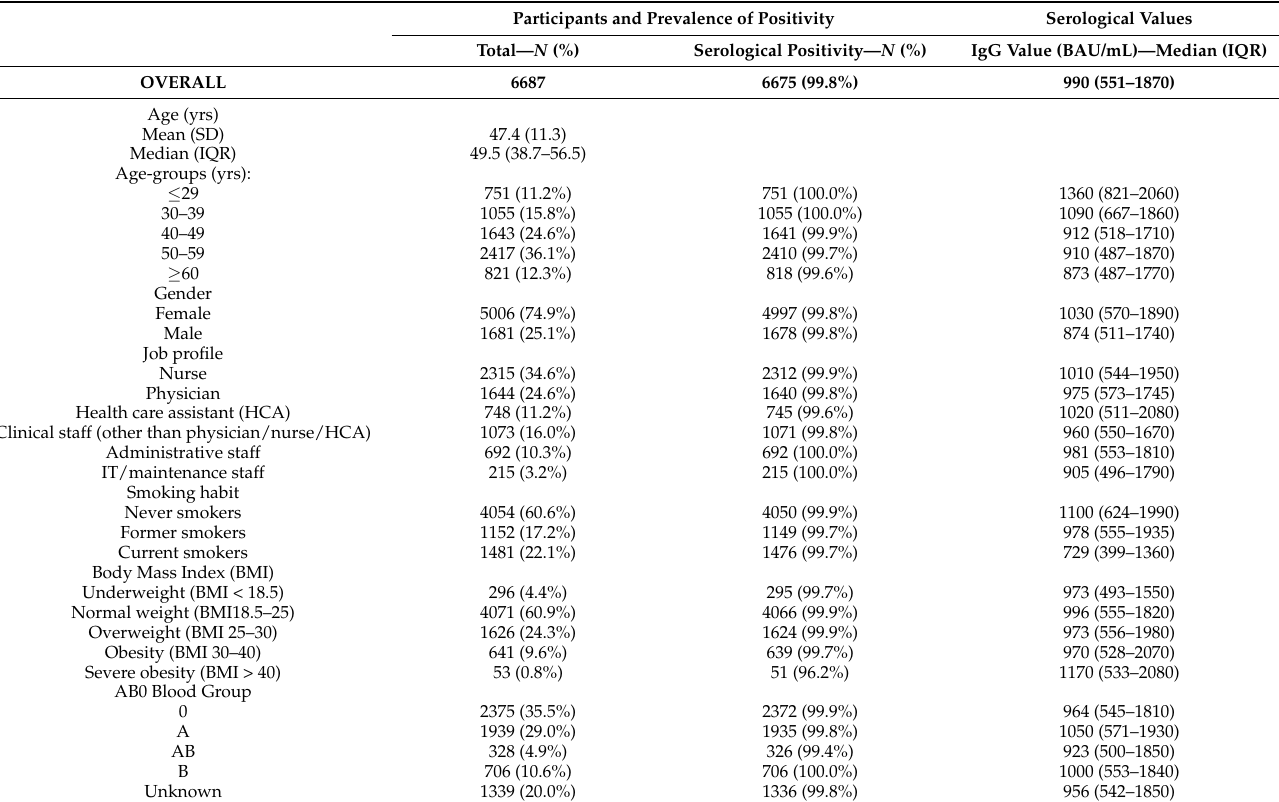
Table 1. Participants (first column), prevalence of seropositivity (second column), and serological values (third column) among 6687 vaccinated HCW of CSS participating in the serological post- vaccination survey on May 2021, by individual and socio-demographic